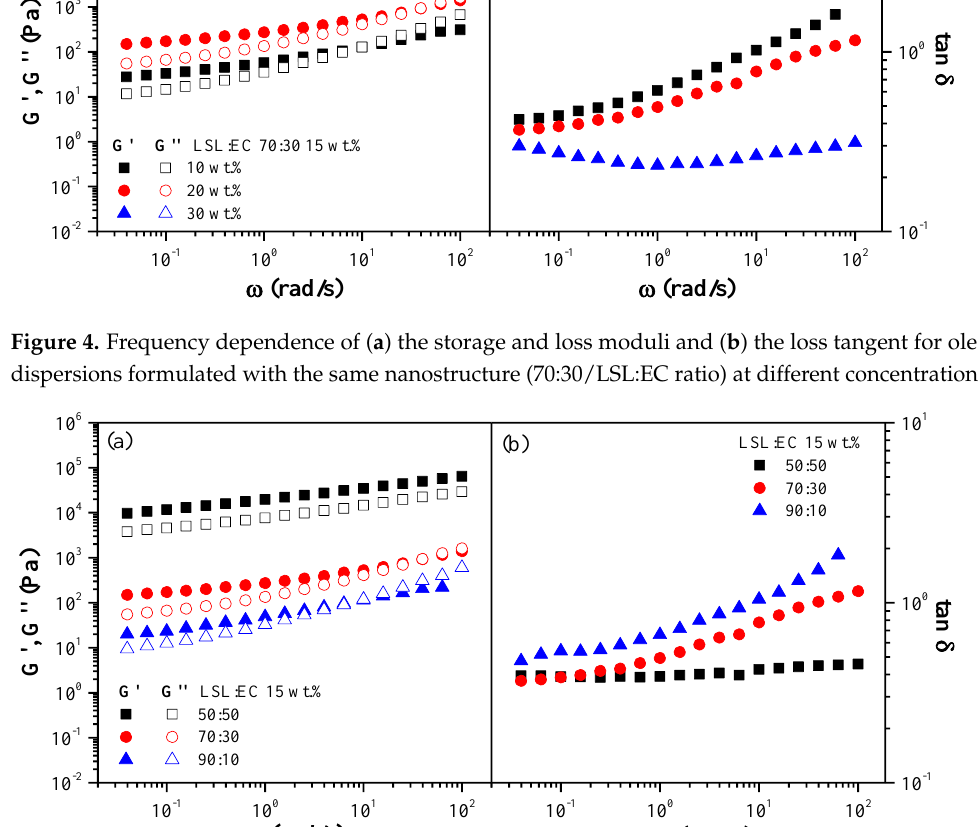
Figure 5. Frequency dependence of ( a ) the storage and loss moduli and ( b ) the loss tangent for oleo-dispersions formulated with nanostructures differing in the LSL:EC ratio (20 wt.% nanostructure concentration).